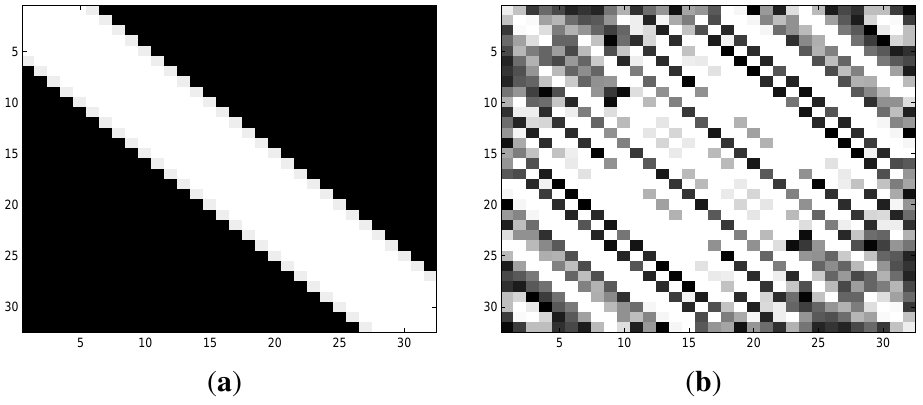
Figure 1. ( a ) Influence matrix for a set of 32 linearly deployed sensor-actuator system with a bounded influence region; ( b ) inverse of corresponding influence matrix (gray-scale shades are used to represent the magnitude of each matrix element, with black denoting zero and white denoting the maximum value).